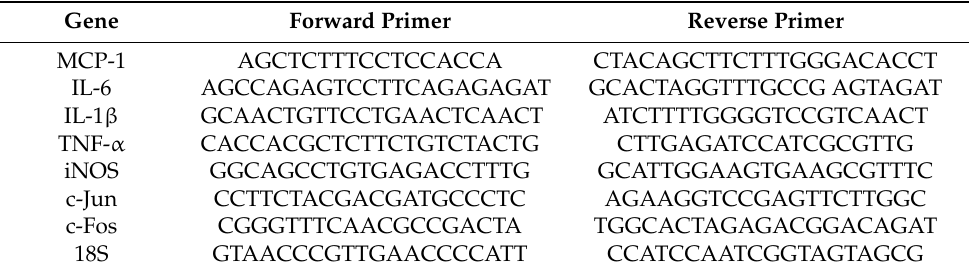
Table 1. Primers used for qPCR